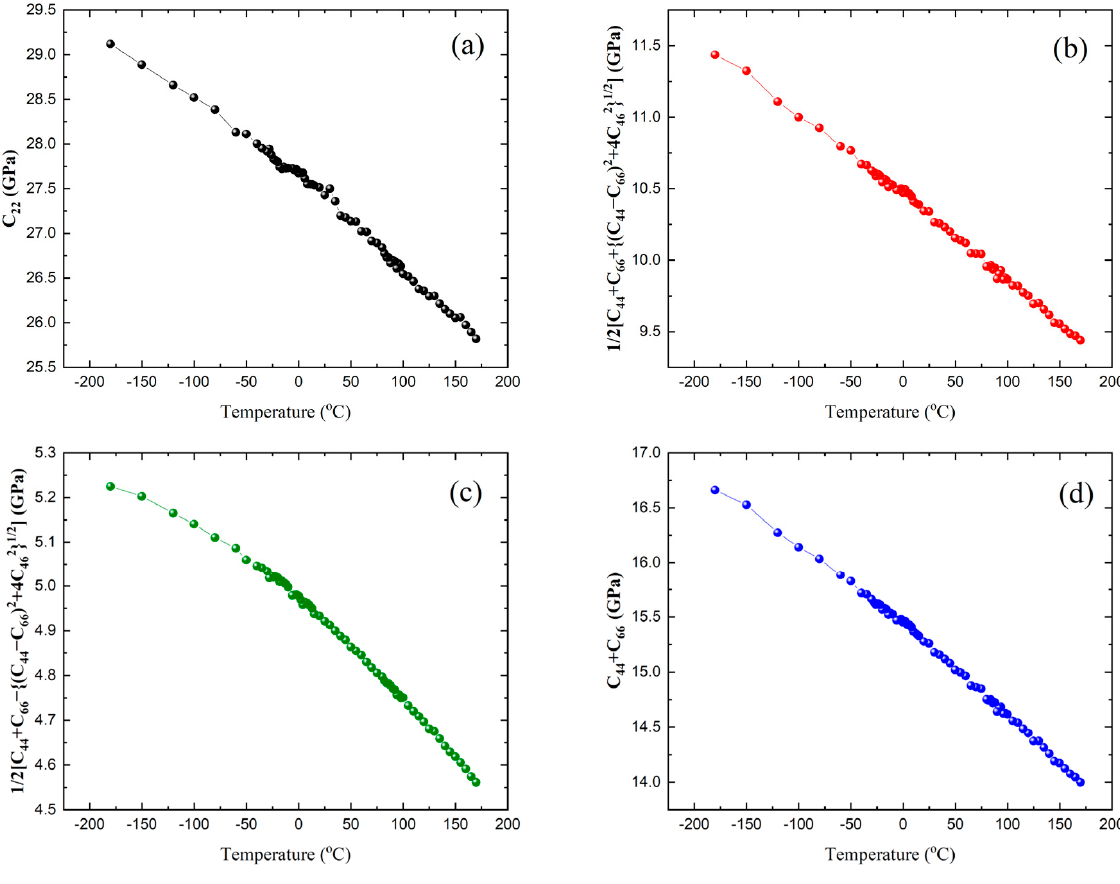
Figure 6. Temperature dependence of ( a ) 𝐶 (cid:2870)(cid:2870) , ( b ) (𝐶 (cid:2872)(cid:2872) + 𝐶 (cid:2874)(cid:2874) + (cid:3493)(𝐶 (cid:2872)(cid:2872) − 𝐶 (cid:2874)(cid:2874) ) (cid:2870) + 4𝐶 (cid:2872)(cid:2874)(cid:2870) /2, ( c ) (𝐶 (cid:2872)(cid:2872) + 𝐶 (cid:2874)(cid:2874) − (cid:3493)(𝐶 (cid:2872)(cid:2872) − 𝐶 (cid:2874)(cid:2874) ) (cid:2870) + 4𝐶 (cid:2872)(cid:2874)(cid:2870) /2, and ( d ) 𝐶 (cid:2872)(cid:2872) + 𝐶 (cid:2874)(cid:2874) . Table 2. The correlation between the three acoustic modes and the elastic constants obtained from the present scattering geometry. The numerical values are measured at 20 °C.